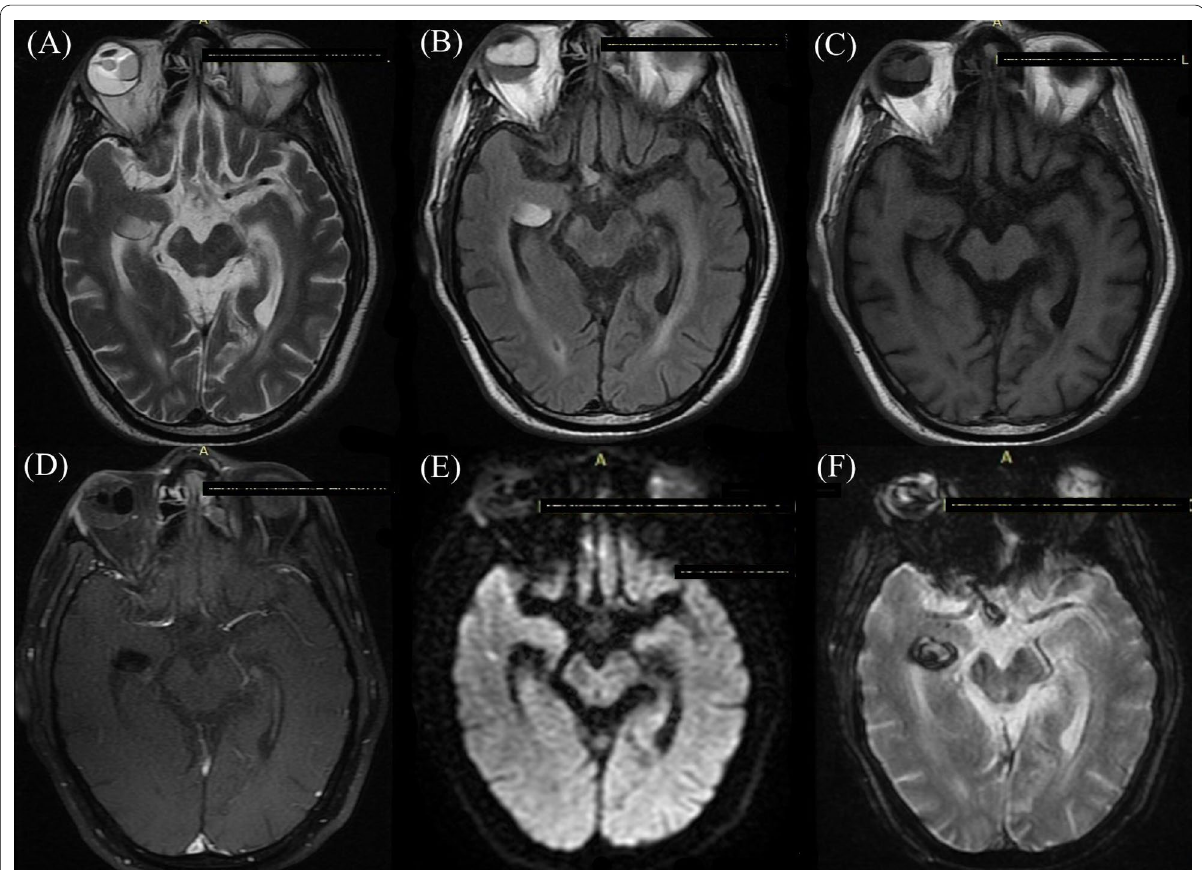
Fig. 5 A Axial T2W MR shows hyperintense silicone oil with characteristic chemical shift artefact within the temporal horn of the right lateral ventricle and the vitreous chamber of the right globe. T2 hyperintensity is also noted in the right side of optic chiasm due to the tracking of silicone oil along the optic nerve. B Axial T2-FLAIR image shows hyperintense silicone oil mimicking intraventricular/intraocular haemorrhage. C Non-contrast Axial T1WI shows hyperintense silicone oil. D Post-contrast Axial T1 Fat Suppressed (T1 FS within the globules. E Axial diffusion-weighted image (DWI) shows a lack of diffusion restriction within the globules. F Axial Gradient Recall